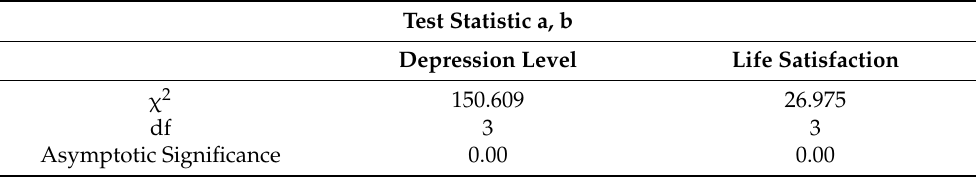
Table 3. Comparison of the cardinal values of the four sample groups.